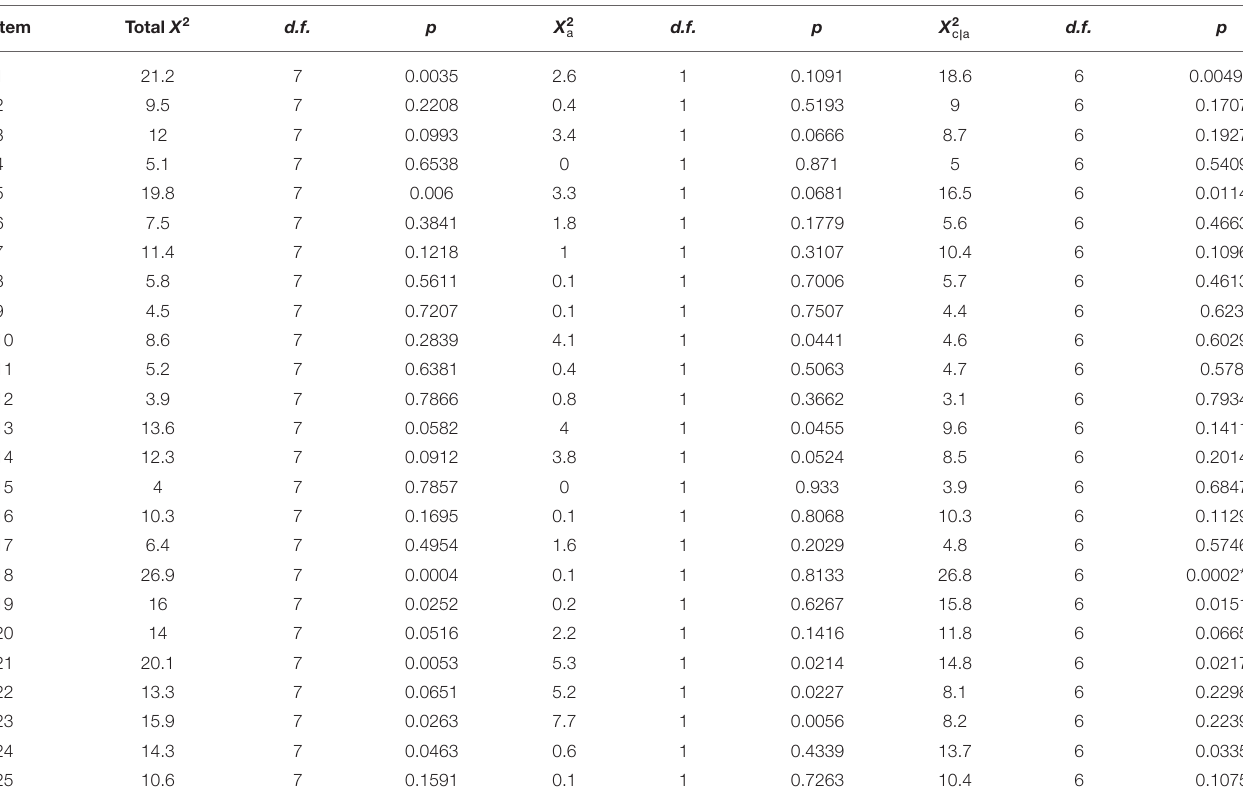
TABLE 5 | DIF statistics for graded response